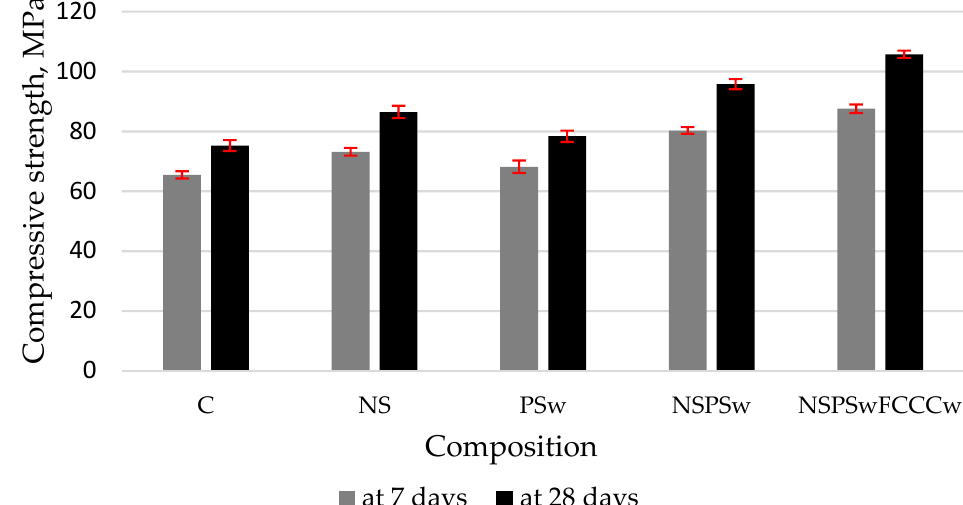
Figure 8. Compressive strength of hardened cement paste at 7 and 28 days.